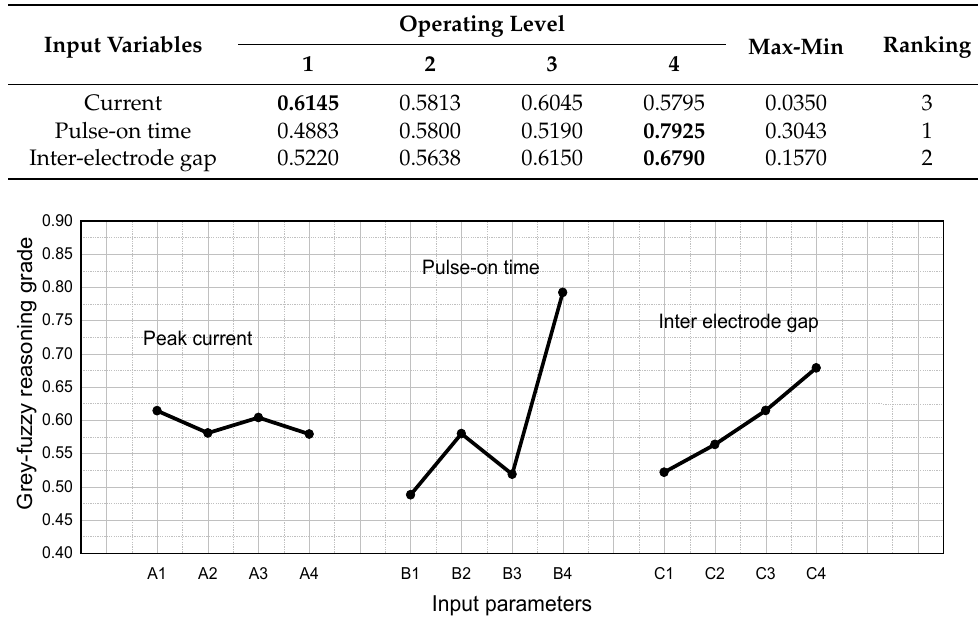
Figure 11. Response graph for GFRG values. Table 9. Response table obtained for GFRG values. The highest GFRG values for unique machining conditions are shown in bold.